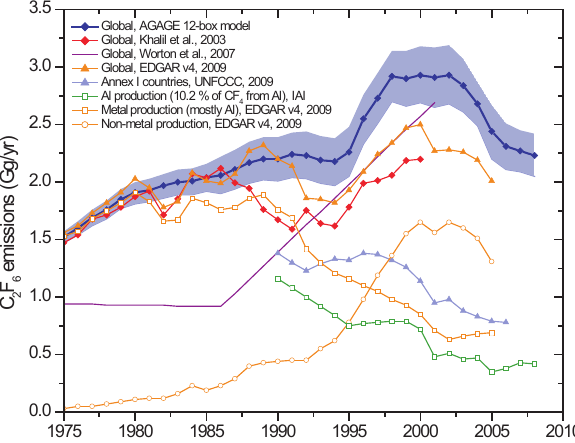
Fig. 5. Global C 2 F 6 emissions from the inversion of AGAGE atmo- spheric data with the AGAGE 2-D 12-box model compared to the emissions reported by Khalil et al. (2003), Worton et al. (2007), the EDGAR v4 (2009) emission database, and Annex I countries (UN- FCCC, 2009, Table S1). Also shown are estimates of C 2 F 6 emis- sions from Al production (10.2% of Al-production CF 4 emissions, IAI Anode Effect surveys), metal production (mostly Al, EDGAR v4, 2009), and non-metal production (EDGAR v4, 2009, > 97% semiconductor/electronics